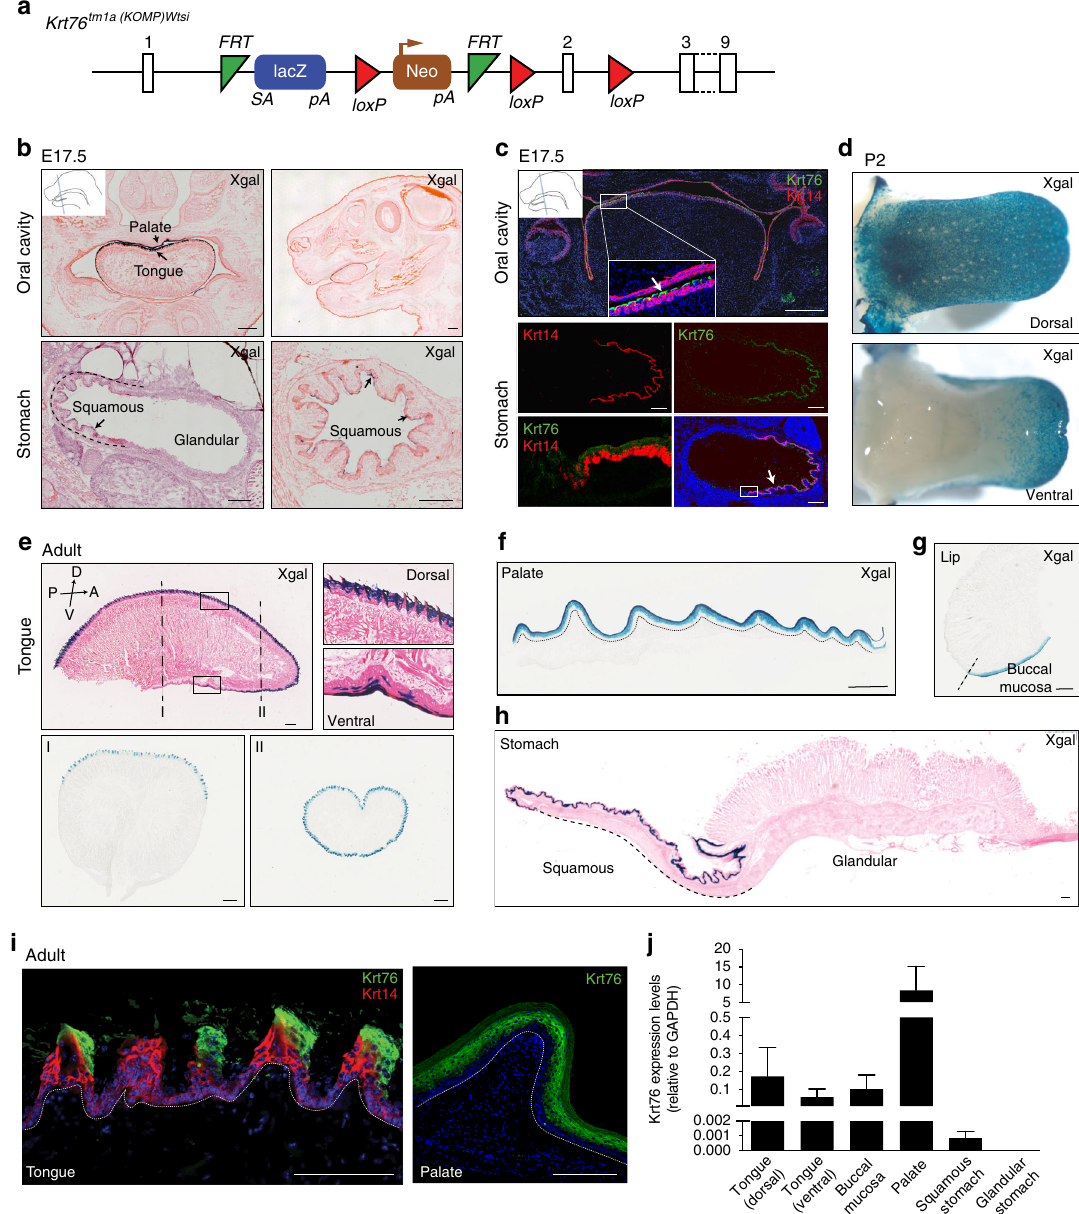
Fig. 1 Keratin 76 is expressed in the oral epithelia and squamous stomach. a Krt76 knockout strategy. Krt76 − / − mice were generated by disruption of the Krt76 gene via a knockout fi rst allele targeting construct (reporter-tagged insertion with conditional potential). These animals have a splice acceptor-LacZ reporter gene integrated in the targeting gene, between exon 1 and 2, which allows tracing of gene expression whilst disrupting Krt76 protein expression. b X-gal staining (blue) of beta-galactosidase expressed under the control of the Krt76 promoter in the oral cavity and stomach (arrows) of Krt76 + / − mouse embryos at E17.5. c Immuno fl uorescence labelling with anti-Krt76 (green) and anti-Krt14 (red) antibodies in the oral cavity and stomach of mouse embryos at E17.5. Bottom row: left hand panel is higher magni fi cation view of boxed area in right hand panel. d Whole-mount X-gal staining of Krt76 + / − reporter mice at post-natal day 2 (P2) shows Krt76 expression in the dorsal and lateral tongue, with partial expression in the ventral tongue. e – h X-gal staining (blue) of beta-galactosidase expressed under the control of the Krt76 promoter in tongue ( e ), palate ( f ), lip and buccal mucosa ( g ) and in stomach ( h ) of Krt76 + / − adult mice. h Mouse stomach is subdivided into two major histologically distinct regions: the squamous stomach lined with a strati fi ed squamous epithelium and the glandular stomach, separated by the limiting ridge from the strati fi ed squamous epithelium of the squamous stomach. Krt76 expression is restricted to the squamous stomach region. i Immuno fl uorescence labelling with anti-Krt76 (green) and anti-Krt14 (red) antibodies of adult wild-type mouse tissues, con fi rming the speci fi city of both anti-Krt76 antibody and X-gal staining. Samples were counterstained with nuclear dye DAPI (4 ′ ,6-diamidino-2-phenylindole). Dotted line delineates basement membrane. j Krt76 mRNA qRT-PCR analysis of adult tissues, relative to Gapdh ( n = 3 mice, means ± s.e.m. are shown). Scale Bars = 500 µ m ( b , c ), 100 µ m ( e – i